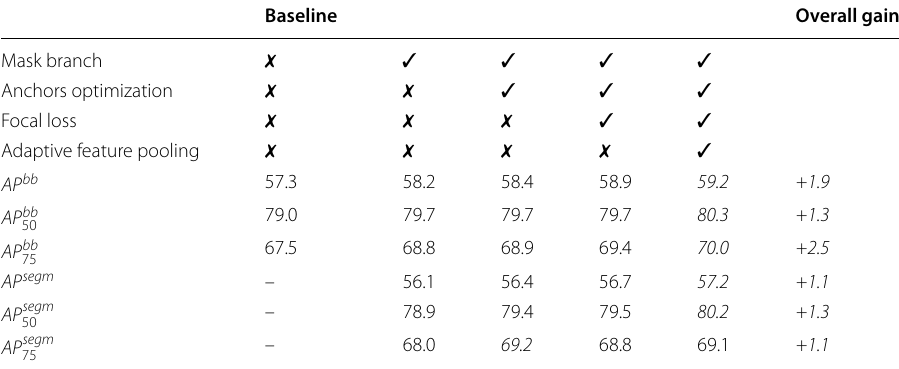
Table 2 Influence of the proposed architectural decisions on the detection network efficiency